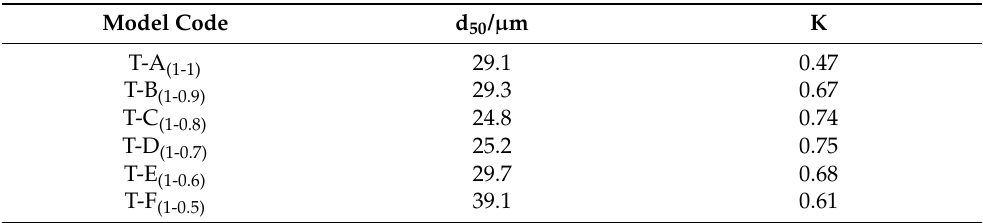
Table 6. Comparison of d 50 and K for the six different rotor cage models (16 m/s–470 rpm). Model Code